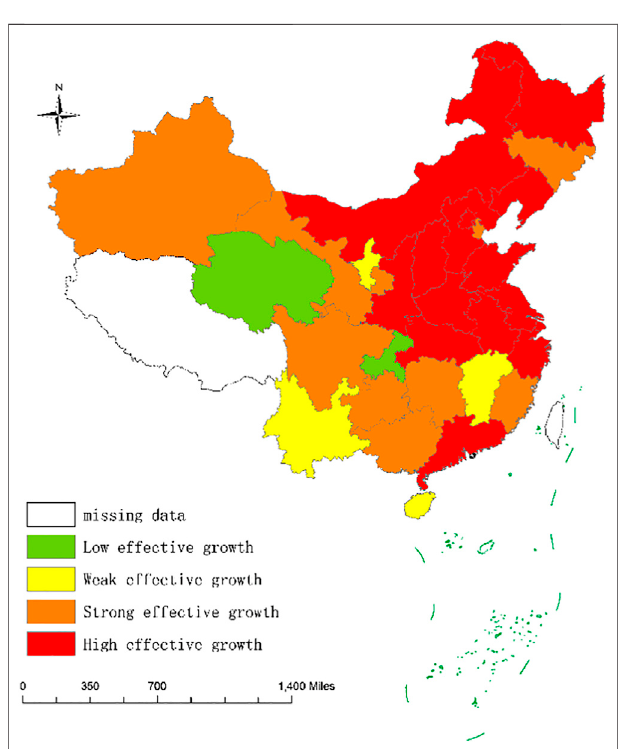
FIGURE 3 | Spatial distribution diagram of